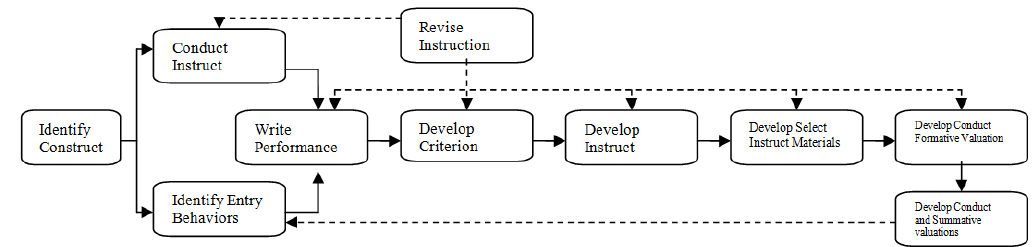
Figure 1. Dick and Carey Design Model (Dick, Carey, & Carey,